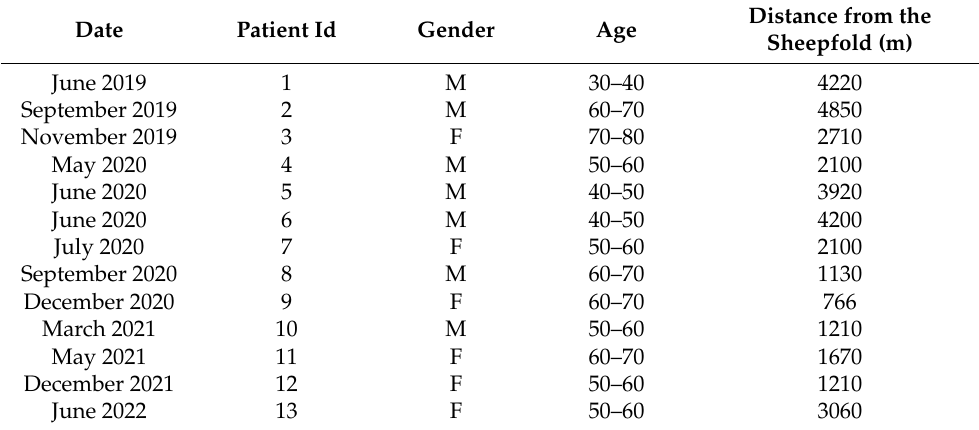
Table 1. Geographical distribution of human cases of Q fever diagnosed between 2019 and 2022 in four French communes in the H é rault